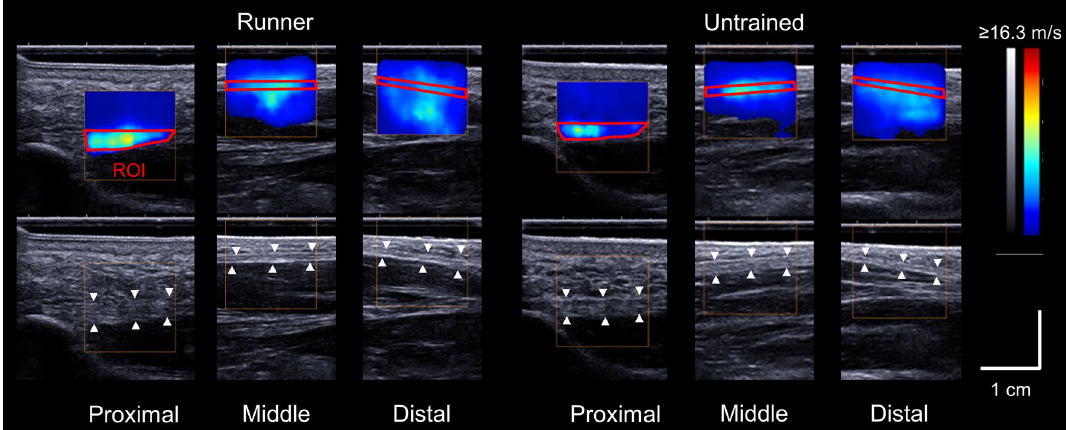
Figure 3. Representative shear wave and ultrasound B-mode images of the plantar fascia at the proximal, middle, and distal sites in a runner and an untrained participant. The region of interest (ROI) is bounded in